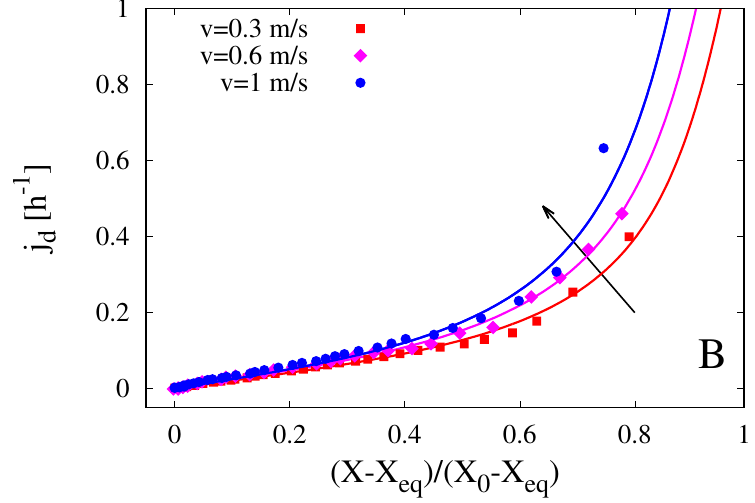
Figure 11. Influence of air velocity v = 0.3,0.6,1 m/s on dehydration kinetics at T = 60 ◦ C. Comparison between experimental data and model predictions with D = 3.12 × 10 − 10 m 2 /s and Bi m = 10.27,13.61,16.93 for v = 0.3,0.6,1.0 m/s, respectively. Arrows indicate increasing values of v and Bi m . ( A ) Rescaled moisture content X / X 0 vs. time (h). ( B ) Dehydration rate j d (h − 1 ) vs. moisture ratio X r